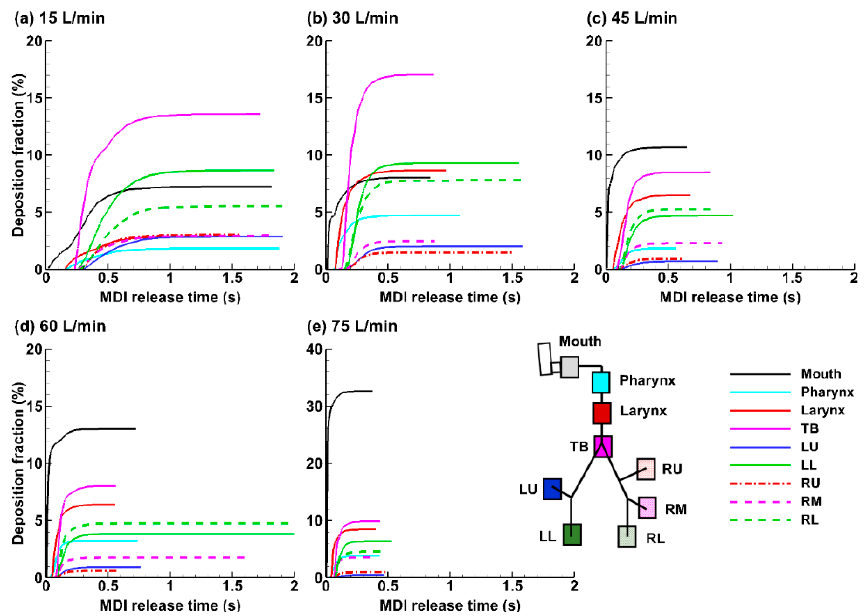
Figure 11. Temporal evolution of the regional deposition fraction (DF) under varying breathing depths (Q max ): ( a ) 15 L/min, ( b ) 30 L/min, ( c ) 45 L/min, ( d ) 60 L/min, and ( e ) 75 L/min.